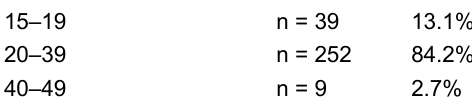
Sociodemographic Characteristics of